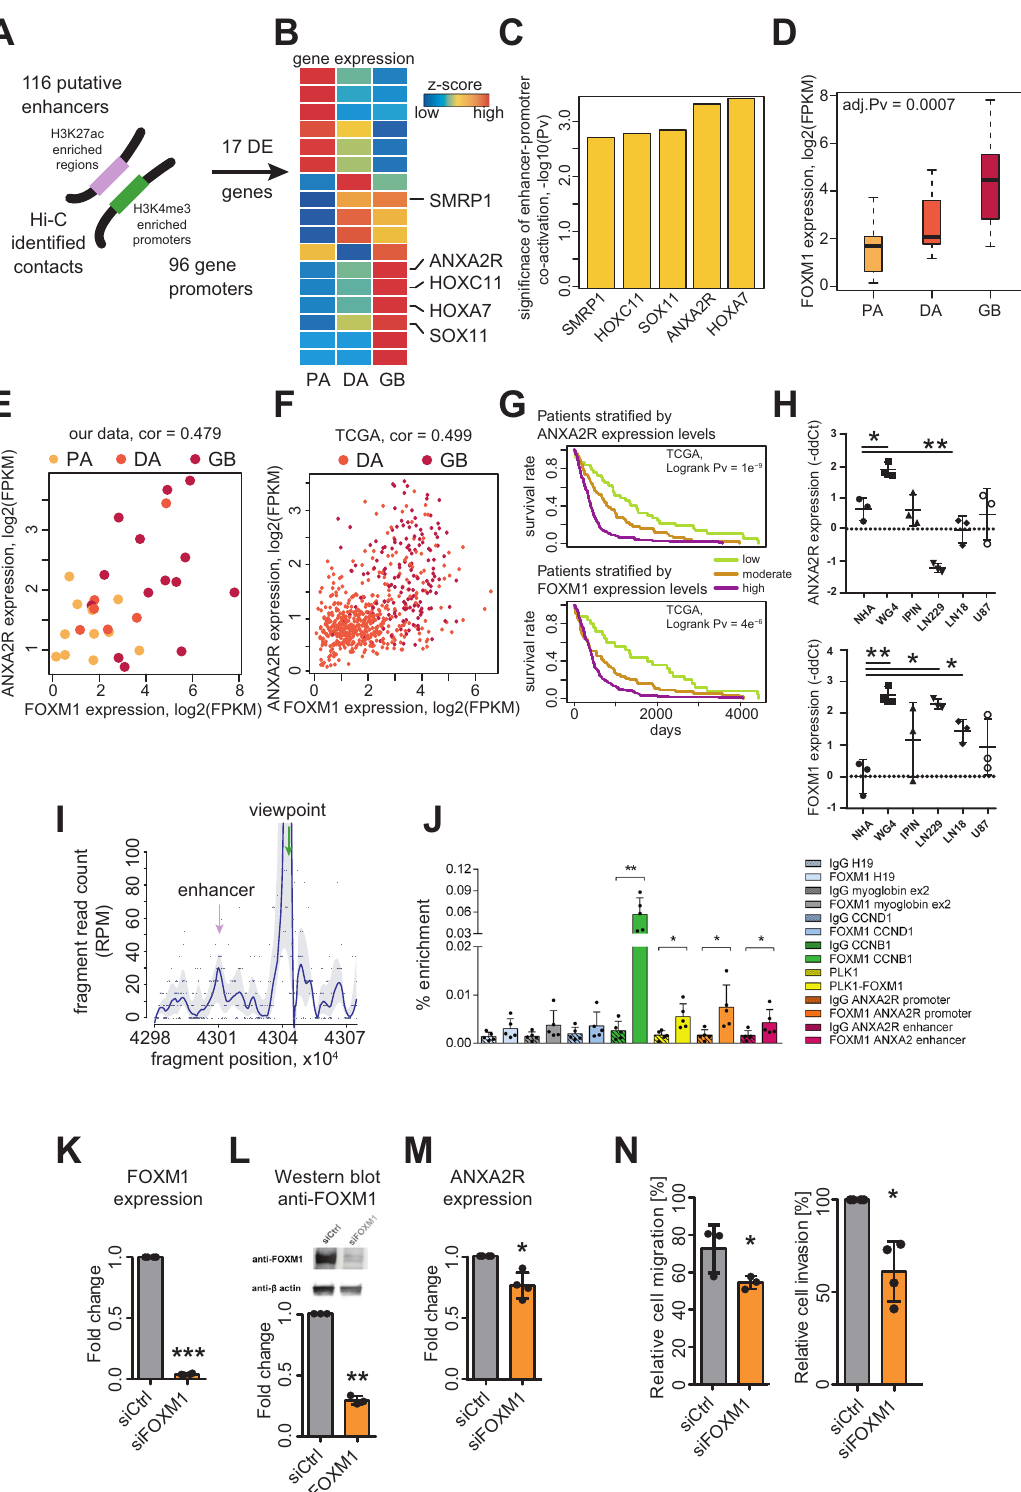
Human glioma samples . Freshly resected glioma specimens were acquired from several neurosurgery clinics: The Children ’ s Memorial Health Institute, Public Central Clinical Hospital, Institute of Psychiatry and Neurology and Mazovian Brodno Hospital. The tissue collection protocol was approved by the Committees of Bioethics of the institutions listed above (protocol number #14/KBE/2012, #KBE/54/2016, #3/2016). Each patient provided a written consent for use of